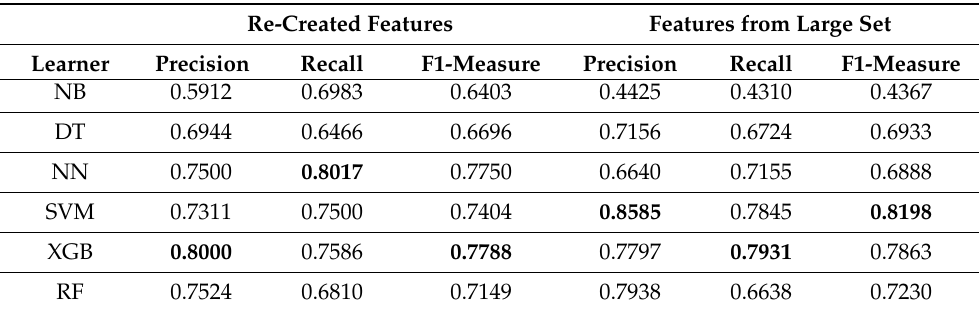
Table 8. Cross validation results on manually labeled gold standard, using tweet features only. We distinguish a setup with re-created features for the manually labeled dataset, and re-using features from the large dataset. The best results are marked in bold.